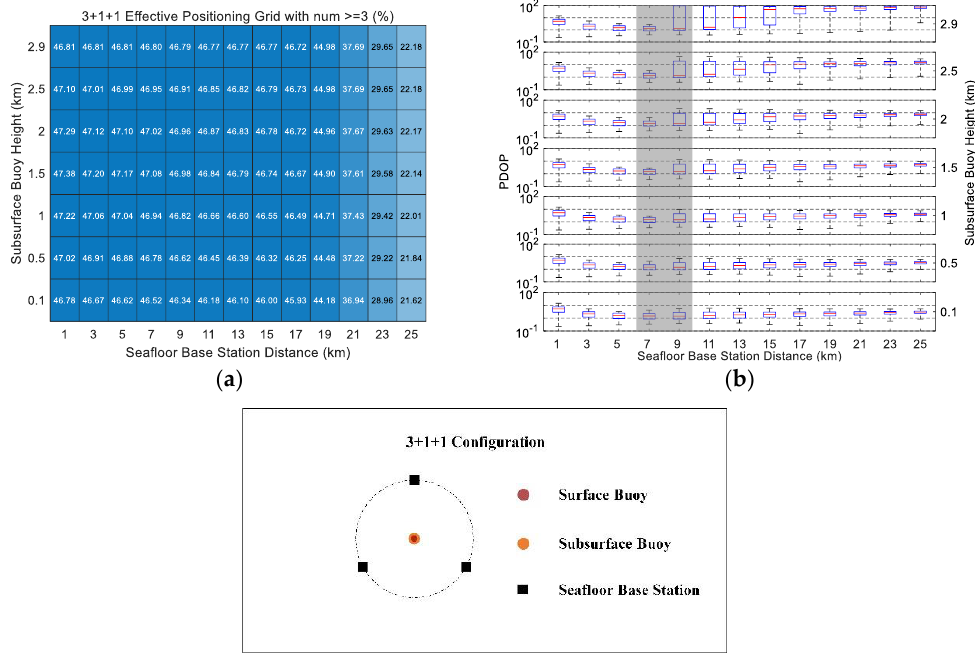
Figure 2. User positioning indicators of the “3+1+1” network configuration. ( a ) Heat map of the percentage of EPGs with the number of available stations ≥ 3. ( b ) Box chart of the PDOP variation with the seafloor base station distance and the subsurface buoy height. The red line denotes the median, the blue box denotes IQR (interquartile range), the solid black lines denote the maximum value and minimum value, respectively, and the ± 1.5 × IQR criterion is used for outlier detection and removal. The shaded area denotes the steep variation of the PODP.